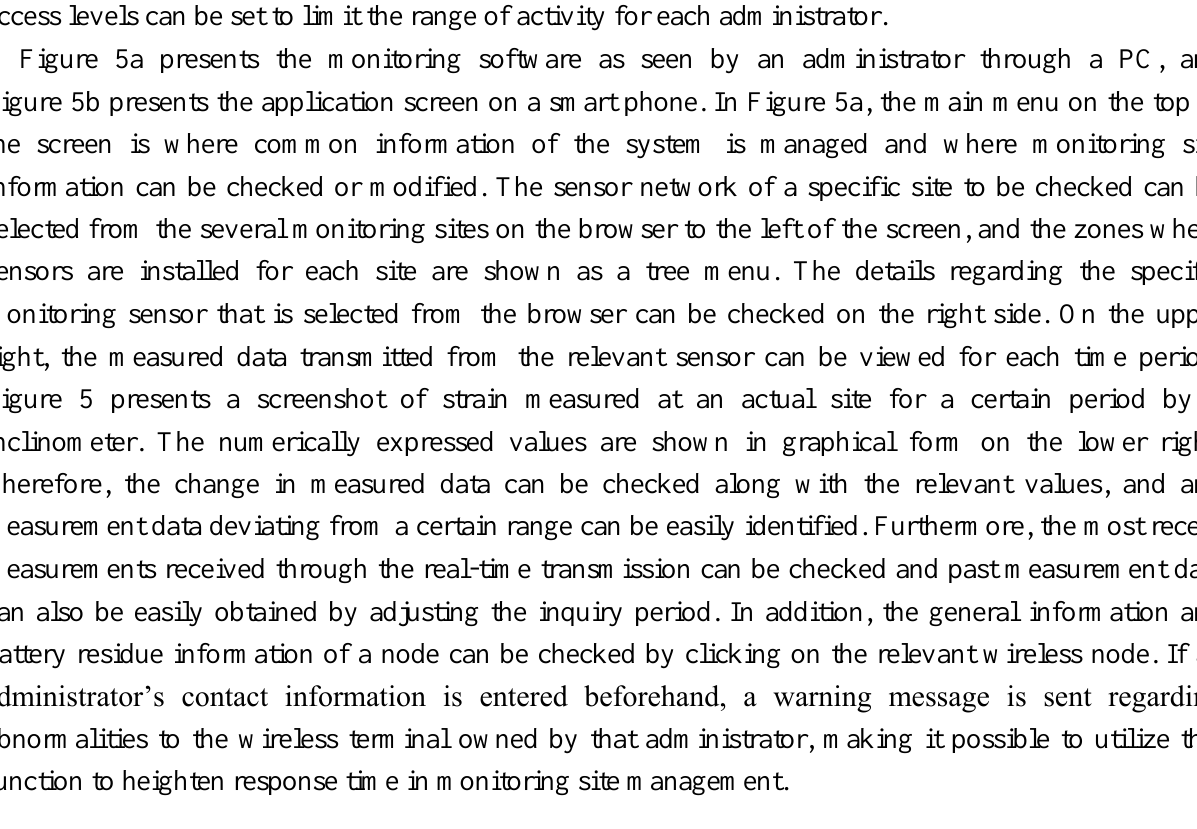
Figure 5. Display of the user interface software program. ( a ) Software program on the monitoring server; ( b ) Application of a mobile